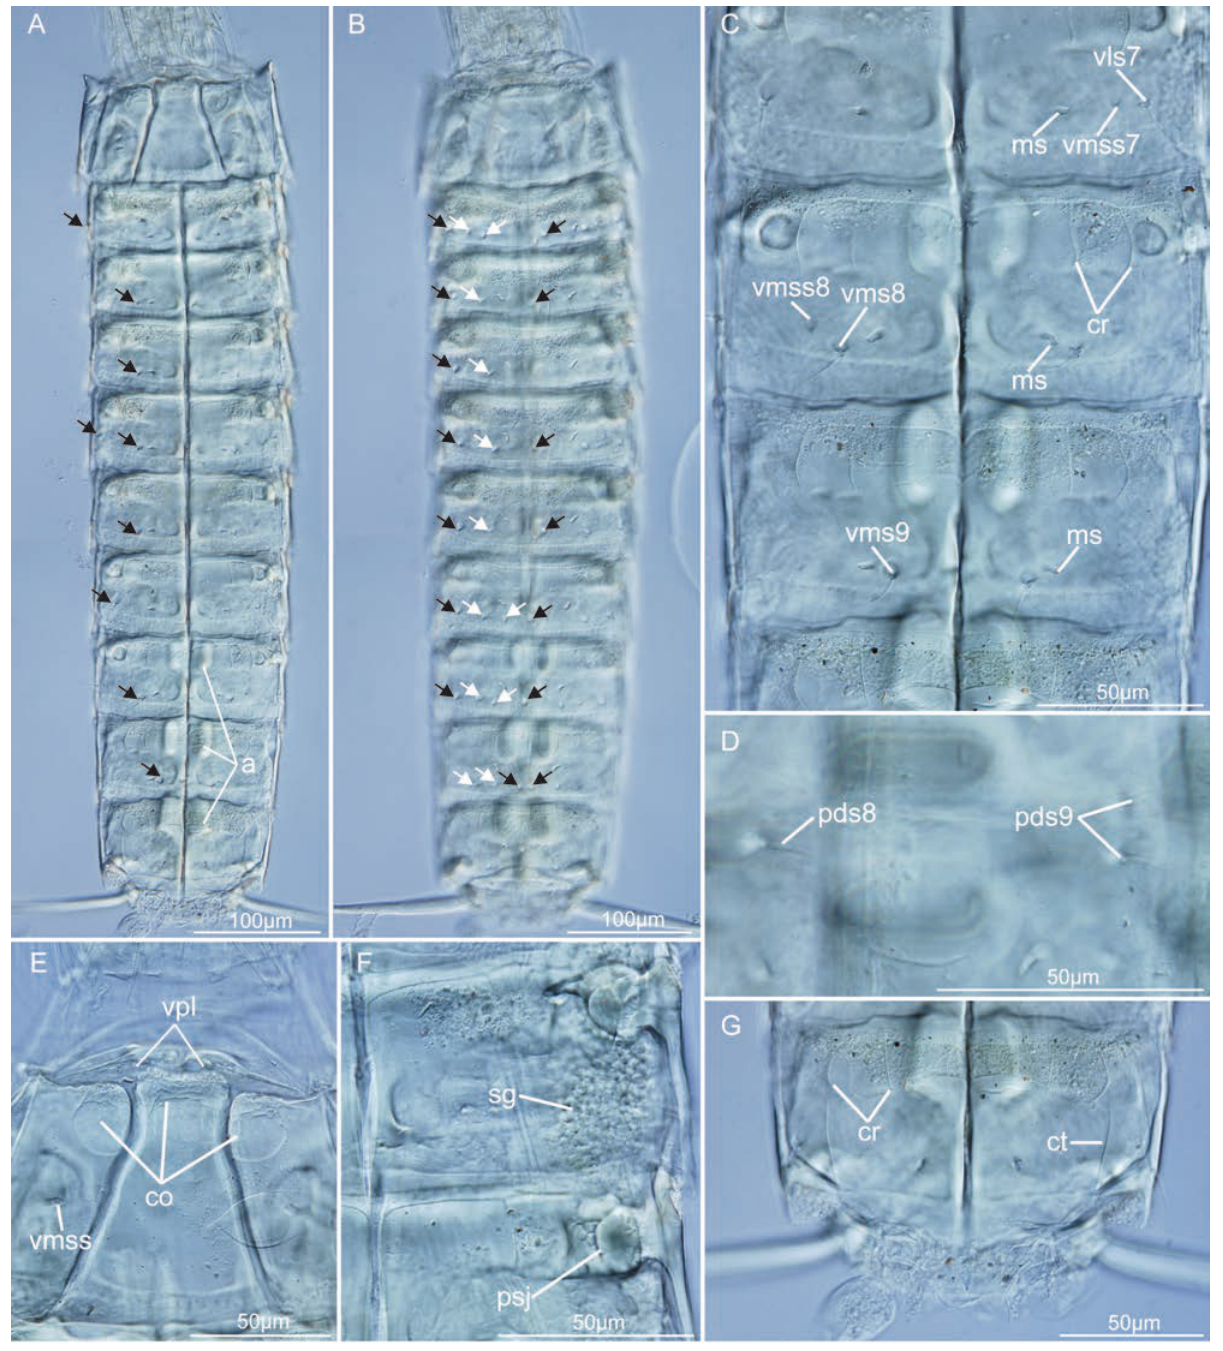
Segment 5: Same as segment 3, but with a pair of ventrolateral setae (Figs 3A-B, 4A-B). 3, but with cuticular wrinkles in the anteriormost region,